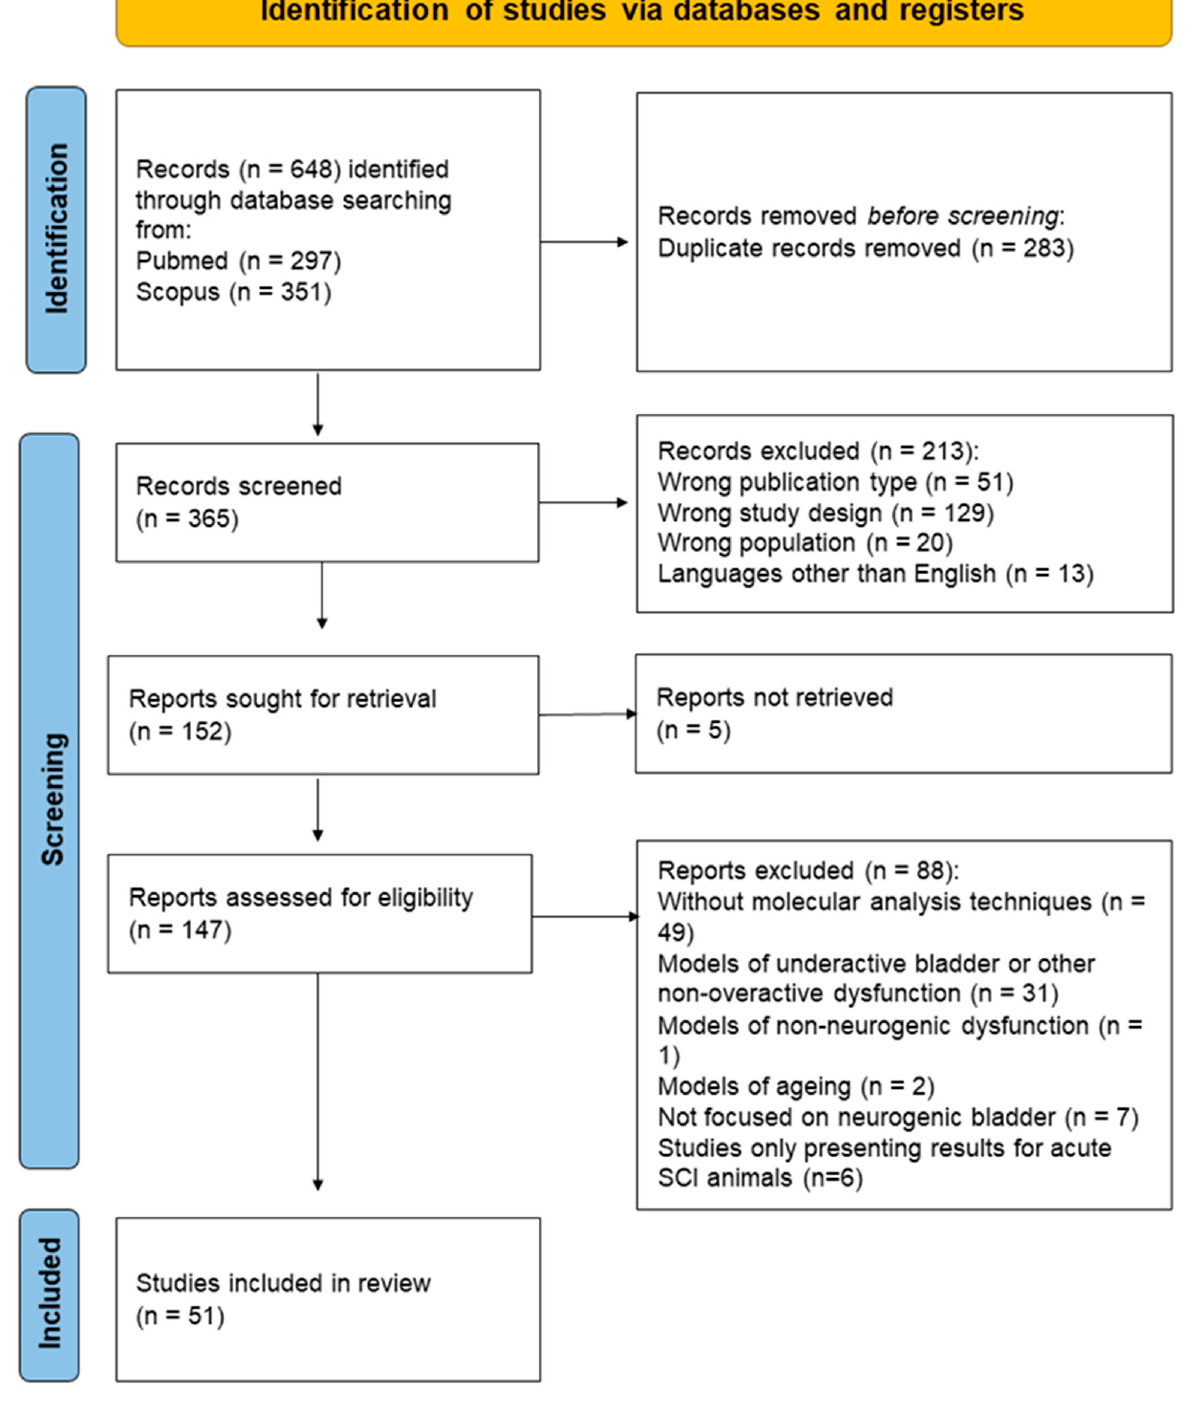
Figure 1. PRISMA flow diagram with the screening process for the present systematic